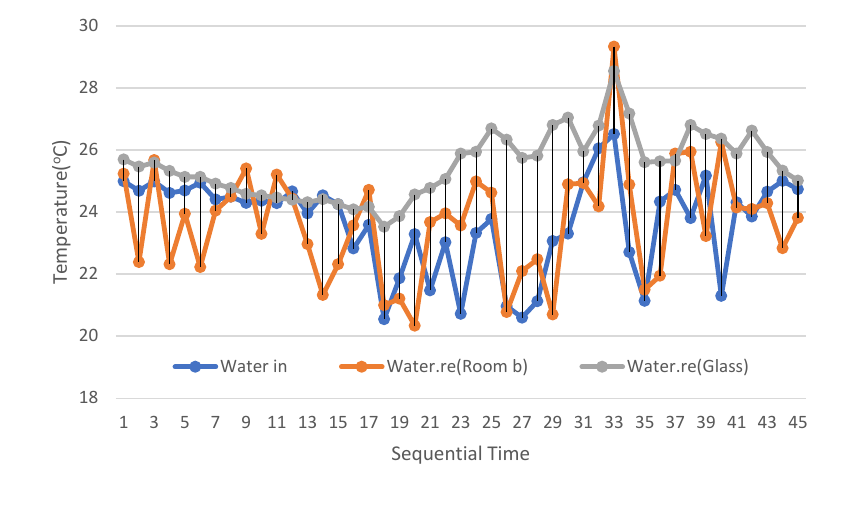
Figure 5. Temperature variations of the radiant cooling system depend on the time-sequential process. The maximum outdoor air temperature was 36.12 °C at p.m. 12:51. Measurements of the glass house were collected for 1 h and 30 min from p.m. 12:51. The returned water was shown to be the highest temperature in the glasshouse. This demonstrates that the